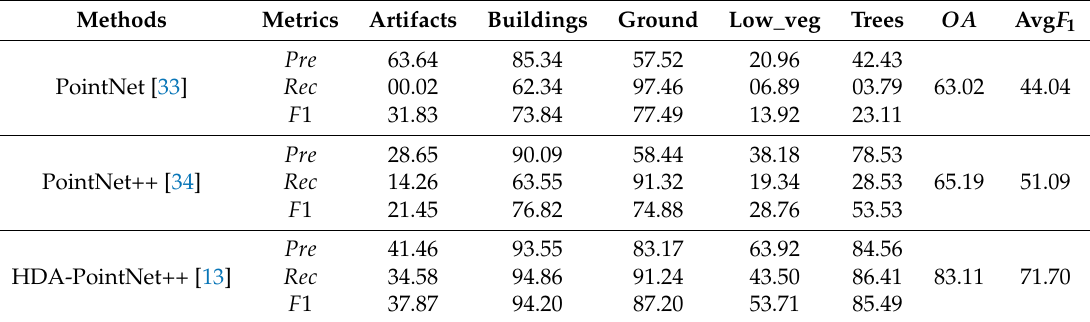
Table 2. Comparison of classification results using the LASDU dataset (no intensities) with different semantic labeling methods (all values are in